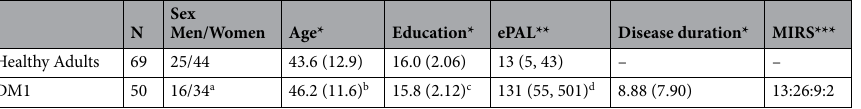
Table 1. Sample characteristics. *in years, mean (SD); **Number of CTG repeats in the longest allele, median (minimum, maximum); ***count per rating, 1:2:3:4; a Χ 2 = 0.08, p = 0.776; b β = 2.68, t = 1.17, p = 0.246; c β = −